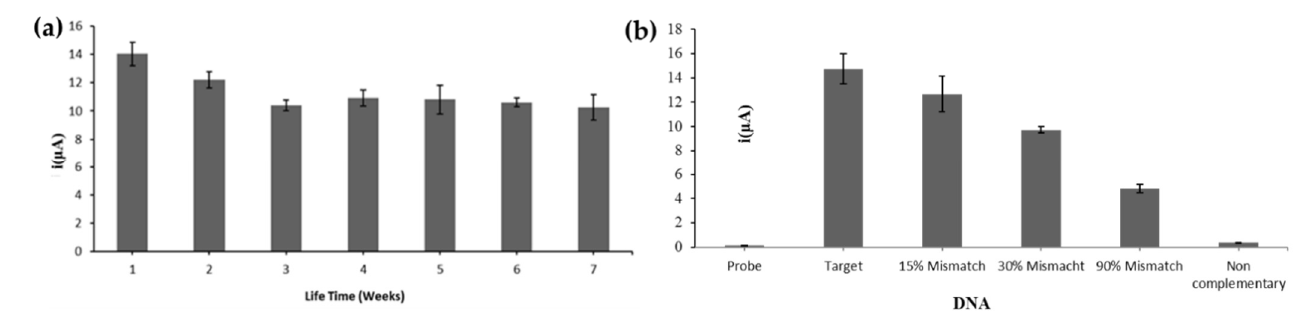
Figure 7. ( a ) The DPV current response of the DNA electrode towards the detection of 1 × 10 − 6 μ M target DNA for seven weeks under the optimal conditions. ( b ) The DNA biosensor response towards 5 µ M target DNA, mismatch DNA and non-complementary DNA with 3 h DNA hybridization time and 1 h AQMS intercalation duration. The DPV measurement was conducted in 0.01 M PBS (pH 7) containing 0.1 M KCl at the scan rate of 100 mVs − 1 .